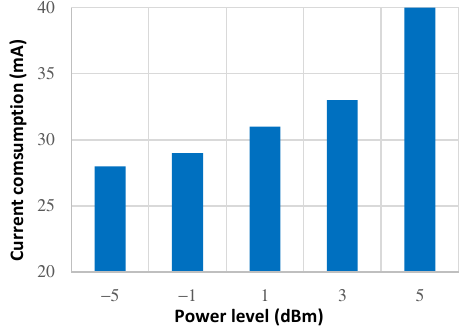
Figure 14. Current consumption of the XBee S2C.